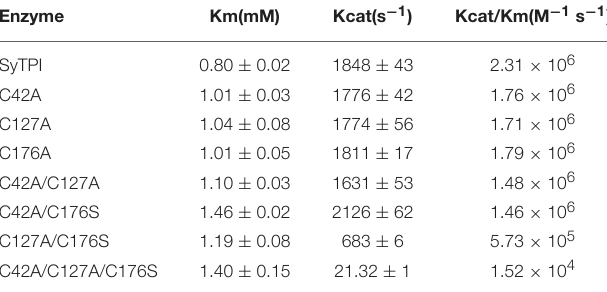
TABLE 1 | Catalytic parameters for G3P and DHAP interconversion by wild-type and mutant